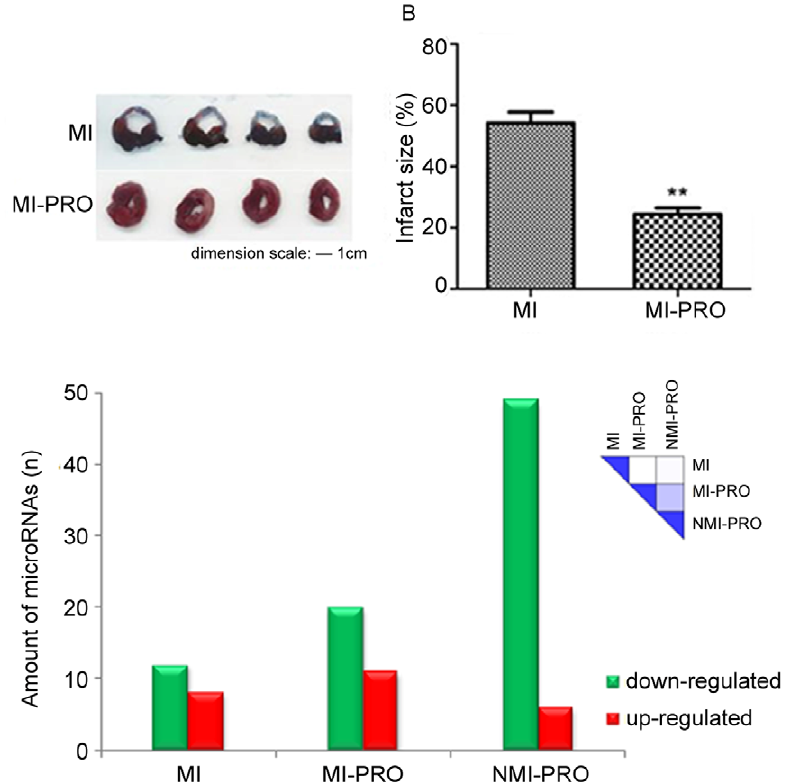
Figure 1. Effects of propranolol on the infarct size and miRNAs expression. A. Effects of propranolol on the infarct size in rats with myocardial infarction. Left panel: the white portion of the coronal sections of the left ventricular wall represents the infarct area. Right panel: the size of infarct area was expressed as the percentage of a standard coronal section. ** p , 0.01 vs. MI (two-way paired t-test), n=5. B. Count of miRNAs with expression levels varied by at least 6 0.5 from the levels in Control. The right upper heatmap shows the miRNA expression similarity between groups. MI, myocardial infarction; MI-PRO, myocardial infarction-propranolol; NMI-PRO, non-myocardial infarction-propranolol. C. Quantification of miR-1 expression. Relative level of miR-1 normalized to control; *** p , 0.0001 vs. control; ## p , 0.01 vs. MI (two-way paired t-test), n=8.